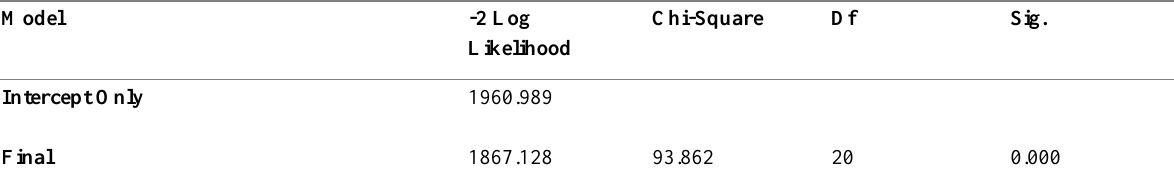
Table 2: Model Fitting Information